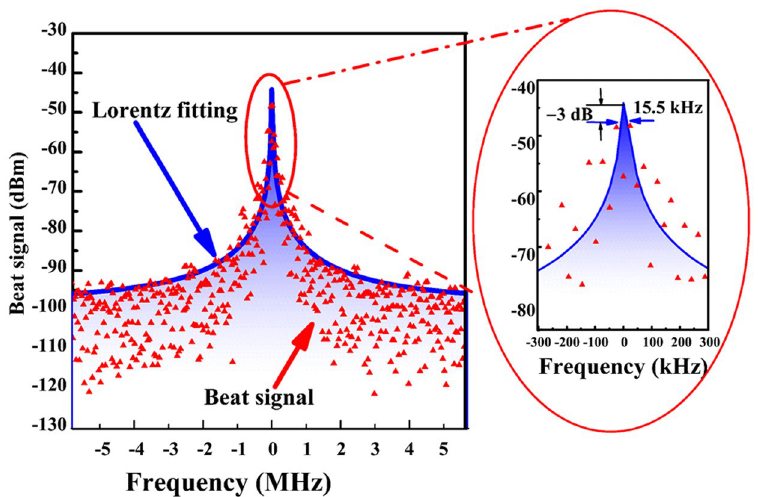
Figure 4. The spectrum of beat note between the Faraday laser (red triangles) and a FBGL with 10 kHz RBW and the Lorentzian fit curve (blue curve). The sweep time of the spectrum analyzer is 5 ms, and the video bandwidth is 10 kHz. The − 3 dB linewidth of the Lorentzian fit curve is 15.5